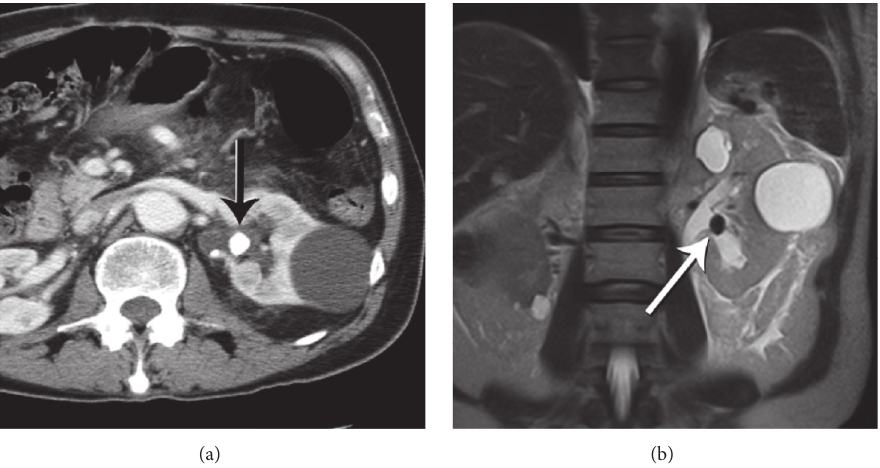
Figure 1: Stone visible on both CT and MR. (a) Enhanced axial CT demonstrates a large stone in the left renal pelvis (arrow). (b) Coronal HASTE MRI image clearly depicts the hypointense stone (arrow) against the backdrop of hyperintense urine.